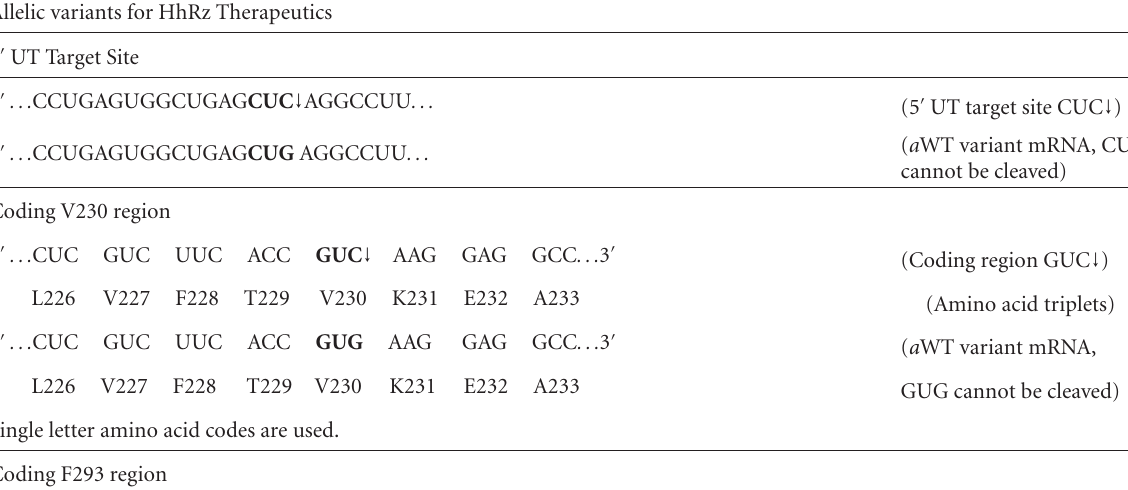
Table 3: Construction of allelic variant genes for combined knockdown reconstitute therapies. Allelic variants for HhRz